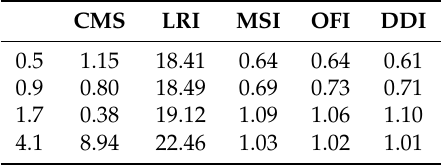
Table A6. Accel.LN in large distance.